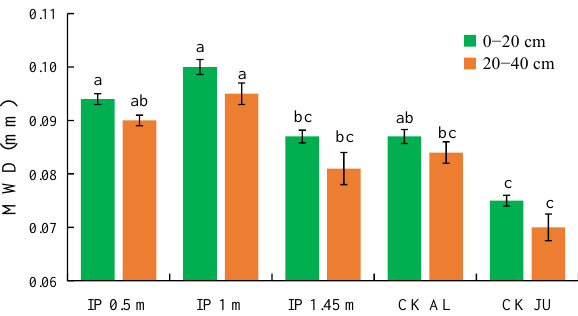
Figure 6. Mean weight diameter (MWD) of soil water-stable aggregates. The letters on the bar de- note the significant differences between the treatments across the two soil depths. the significant differences between the treatments across the two soil depths.